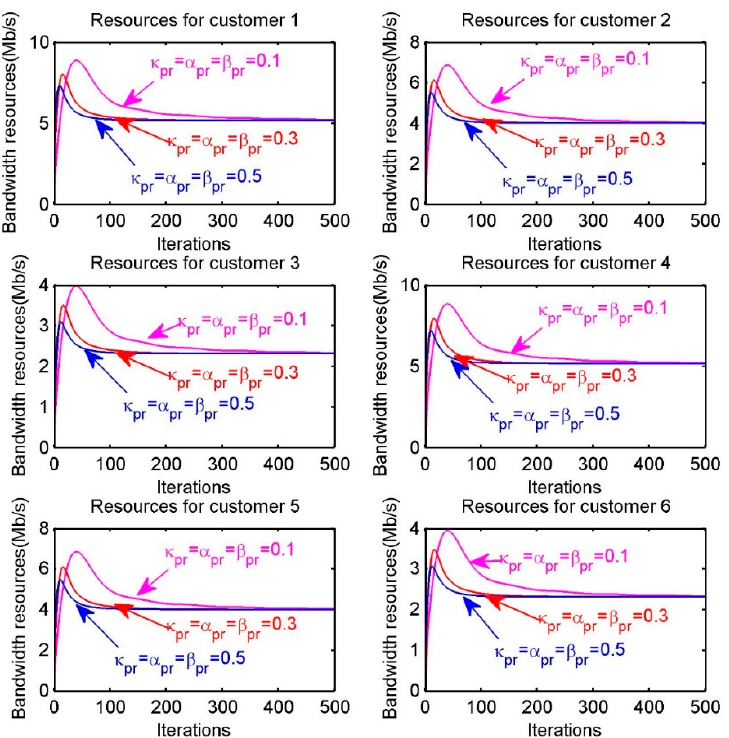
Figure 12. Resources allocation of each customer 𝑟 when choosing different step sizes.